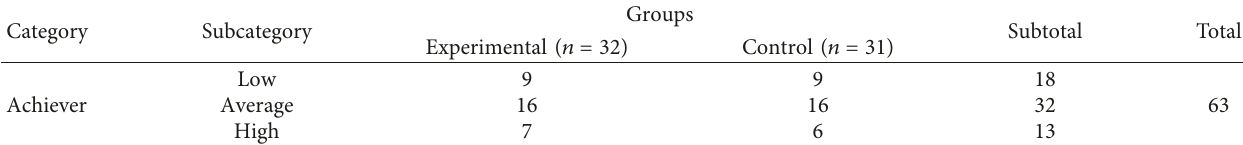
Table 1: Details of the sample selected for the experimental and the control